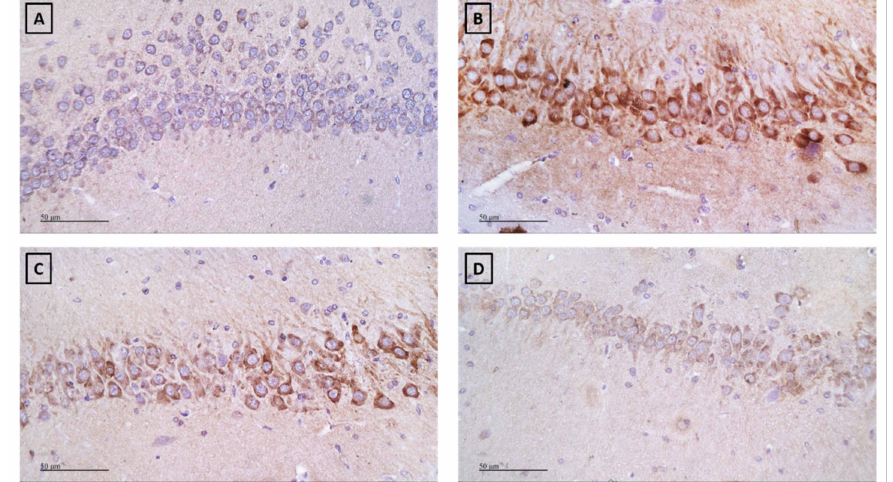
Figure 7. Immunohistochemical staining of COX-2 in the hippocampus (x 400, n = 3). ( A ) The saline group showing no expression; ( B ) LPS group showing strong positive expression; ( C ) LPS + Xanthotoxin group showing weak positive expression; ( D ) LPS + Umbelliferone group showing much weaker positive expression (immunopositivity is indicated by brown